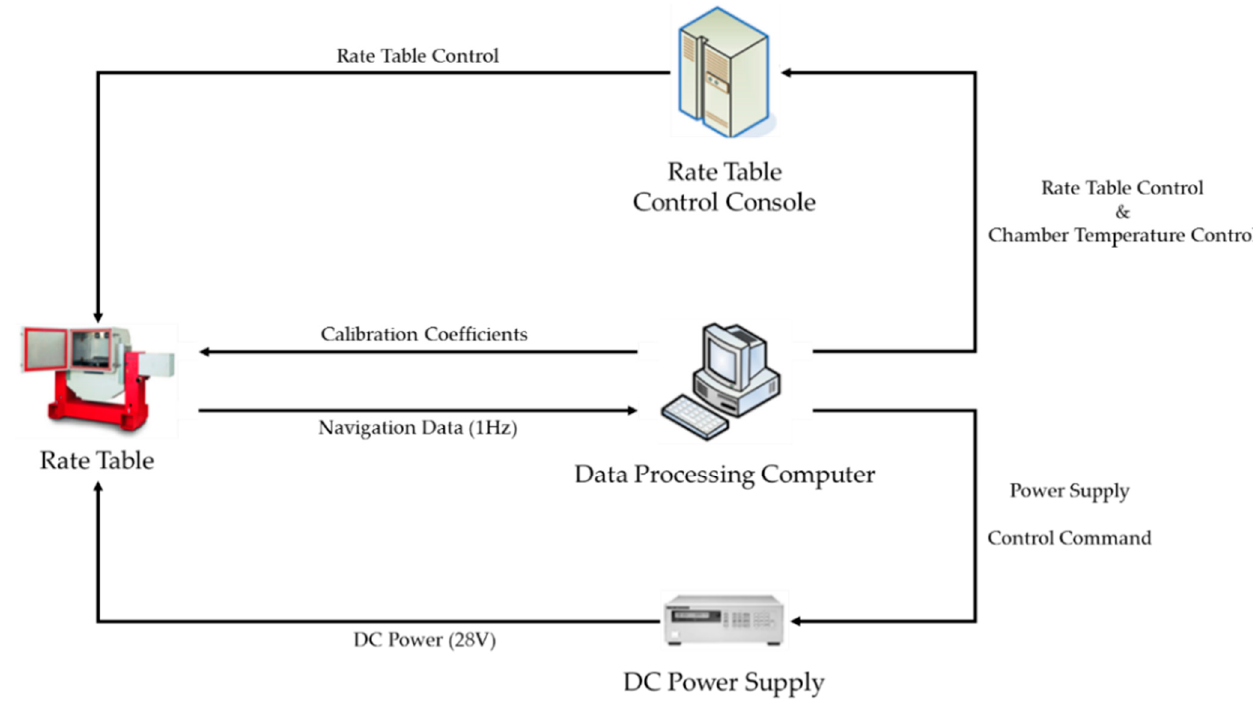
Figure 6. Calibration test diagram.